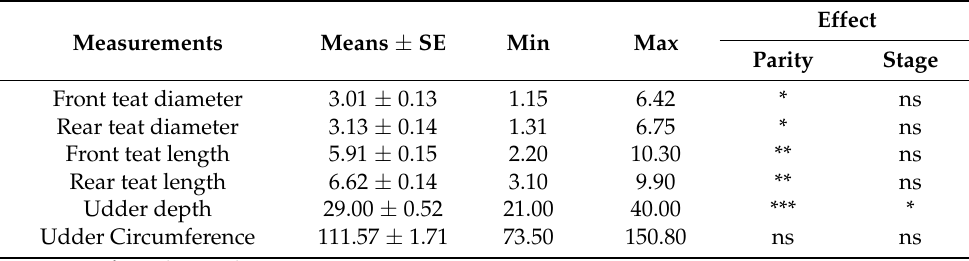
Table 1. Mean values of udder and teat measurements (cm) and effect of lactation stage and parity in dairy dromedary camels.